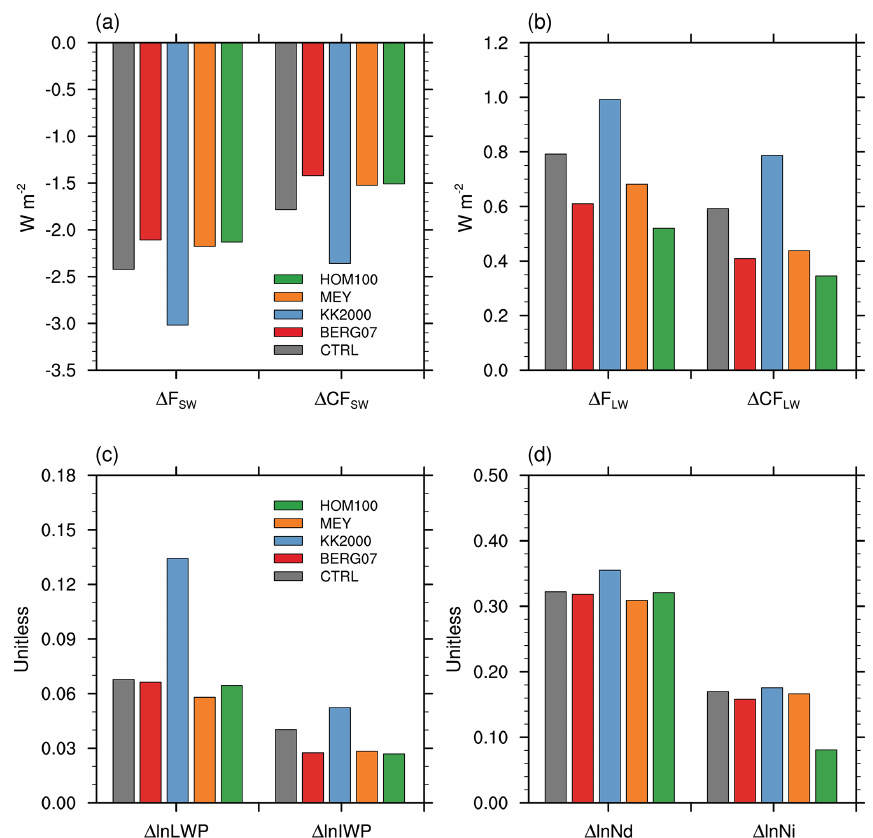
Figure 16. Global annual mean anthropogenic aerosol effects on top-of-model (TOM) radiative fluxes ( (cid:49) F and (cid:49) CF) and hydrometeor mass and number (relative changes) in the reference and sensitivity simulations. CF SW and CF LW are shortwave and longwave cloud radiative forcings. LWP and IWP are the liquid and ice water path in stratiform clouds. N d and N i are the column-integrated droplet and ice number concentrations. (cid:49) ln X = (cid:49)X/X PD . See Sect. 6 for